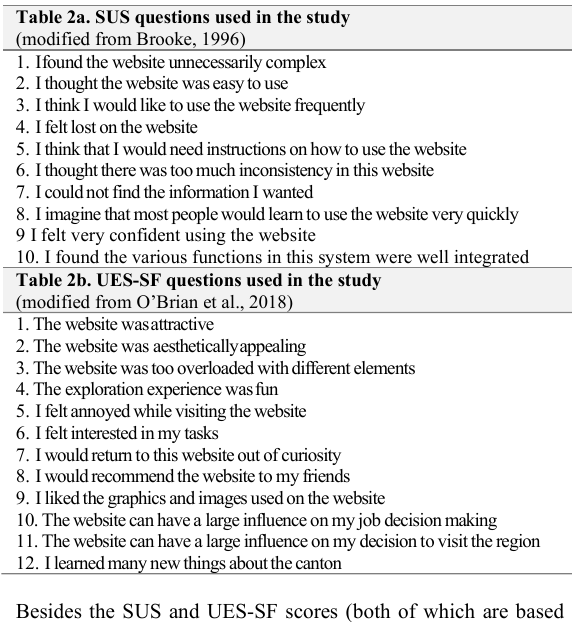
Table 1. List of software libraries used in building the prototype. Name